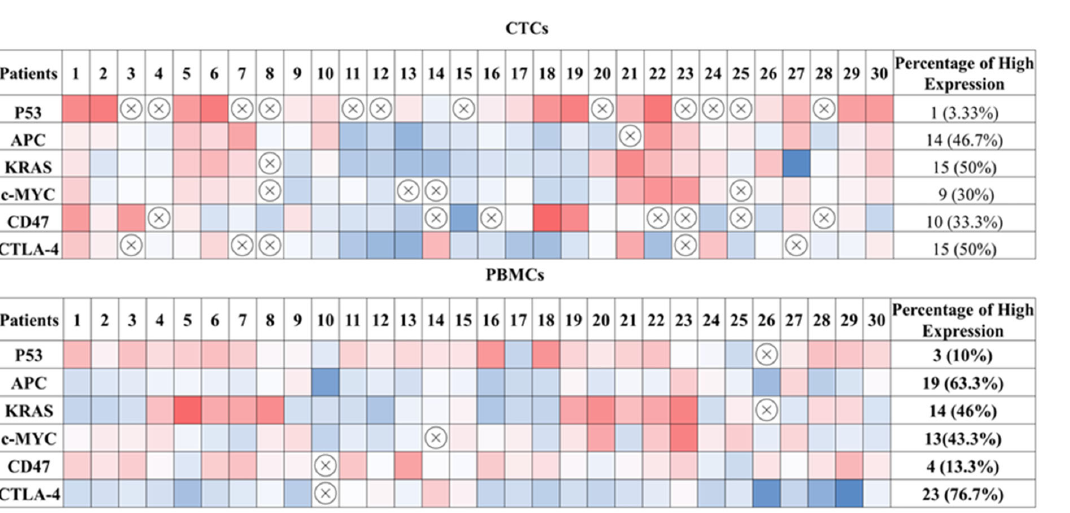
Figure 5. Relationship of the gene expressions ( P53 , APC , KRAS , c-Myc , CD47 and CTLA-4 ) between high and low CTC groups in CTCs and PBMCs, in patients with CRC.